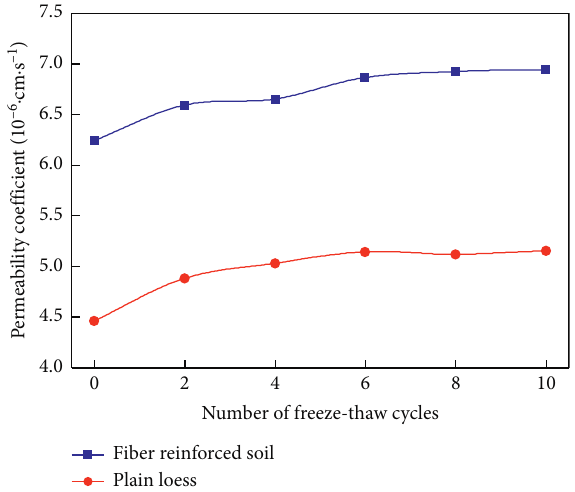
Figure 8: The effects of F-T cycles on permeability with the number of cycles.